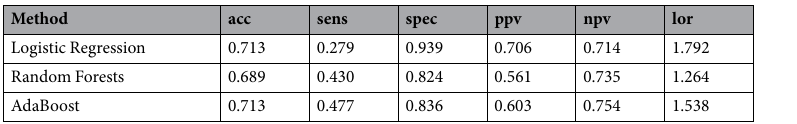
Table 26. Performance of the prediction of TD/PIGD label on the aggregated